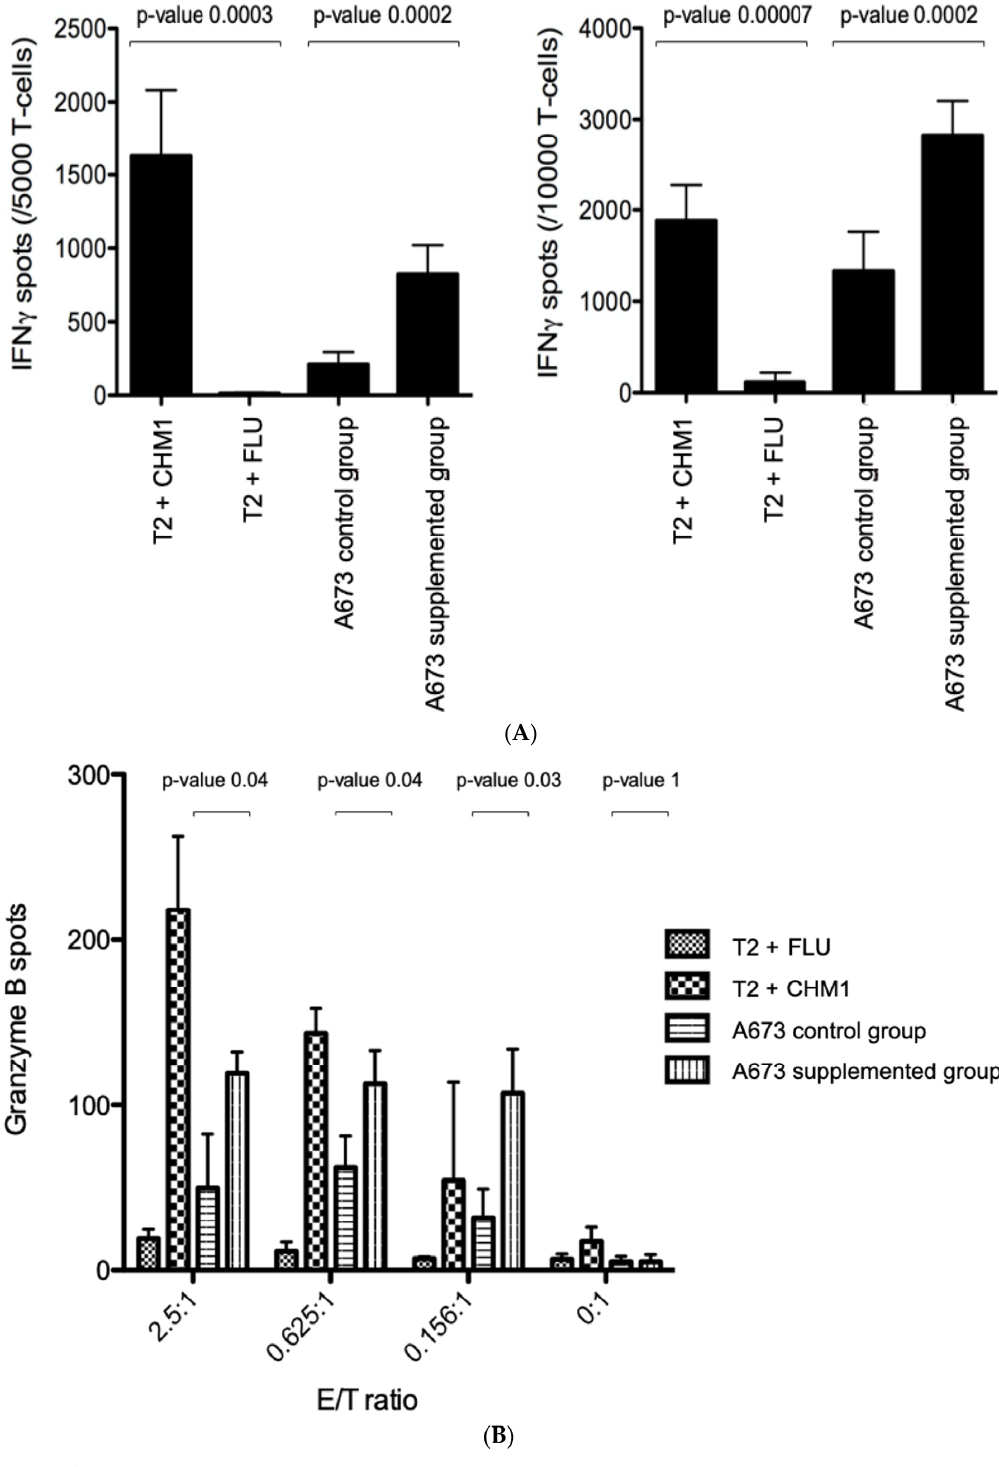
Figure 4. CHM1 319 /HLA-A*02:01-specific T cell-mediated recognition and killing of A673 EwS cell lines and T2 pulsed cells in interferon- γ and granzyme B ELISpot assays. Error bars indicate standard deviation of sextuplicates. ( A ) Interferon- γ ELISpot assays; A673 and CHM1 319 peptide-loaded T2 cells are specifically recognized by CHM1 319 /HLA-A*02:01-specific T cells as compared to T2 cells loaded with influenza-derived control peptides. A673 supplemented with DC maturation cytokines, induce a significantly higher interferon- γ secretion as compared to control A673 cells when 5.000 or 10.000 effector cells were used, respectively (both p < 0.05). ( B ) Granzyme B ELISpot assay; Dose-dependent CHM1 319 /HLA-A*02:01- specific T cell-mediated killing of A673 and T2 cells loaded with CHM1 319 compared to influenza control peptide loaded T2 cells (FLU). A673 supplemented with DC generation-associated cell mediators induce a significantly higher granzyme B secretion compared to control A673 cells in effector to target ratios of 2.5 ( p = 0.04), 0.625 ( p = 0.04) and 0.156 ( p =